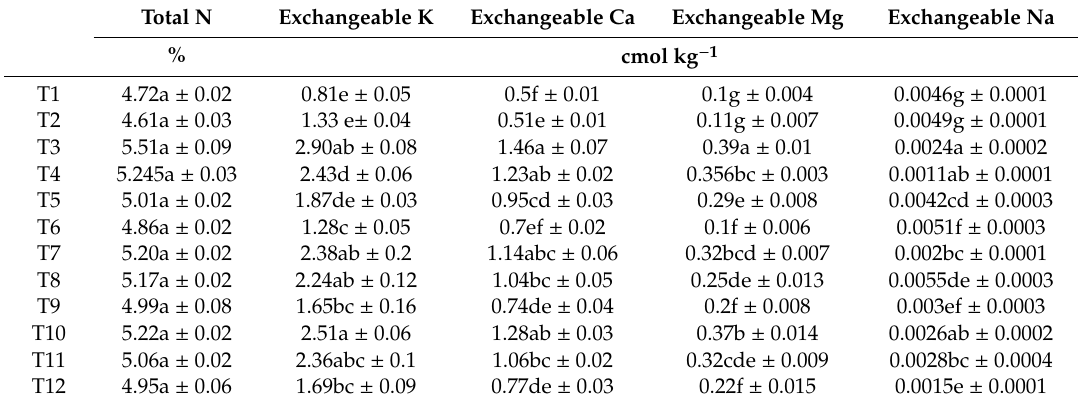
Figure 16. E ff ects of treatments on soil cation exchange capacity. Di ff erent letters indicate significant Figure 16. Effects of treatments on soil cation exchange capacity. Different letters indicate significant di ff erence between means using Tukey’s HSD (Honestly Significant Di ff erence) test at p ≤ 0.05. The difference between means using Tukey’s HSD (Honestly Significant Difference) test at p ≤ 0.05. The error bars are the ± standard error of triplicates. Figure 16. Effects of treatments on soil cation exchange capacity. Different letters indicate significant error bars are the ± standard error of triplicates. Table 11. Chicken litter biochar and triple superphosphate on soil exchangeable cations after pot difference between means using Tukey’s HSD (Honestly Significant Difference) test at p ≤ 0.05. The error bars are the ± standard error of triplicates.